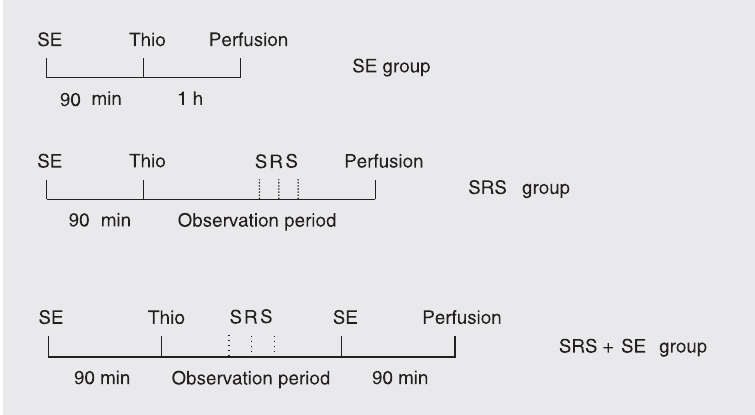
Figure 1. Schematic representation of the protocol used for the three experimental groups. Status epilepticus (SE) was induced in rats which were perfused 2.5 h later (SE group), or after a single or a cluster of stage IV-V spontaneous recurrent seizures (SRS group), or after a second bout of SE (SRS + SE group). All groups were handled and observed together over the same period of time. The observation period refers to 1-15 months for the SRS group and 6-7 months for the SRS + SE group. Thio = sodium